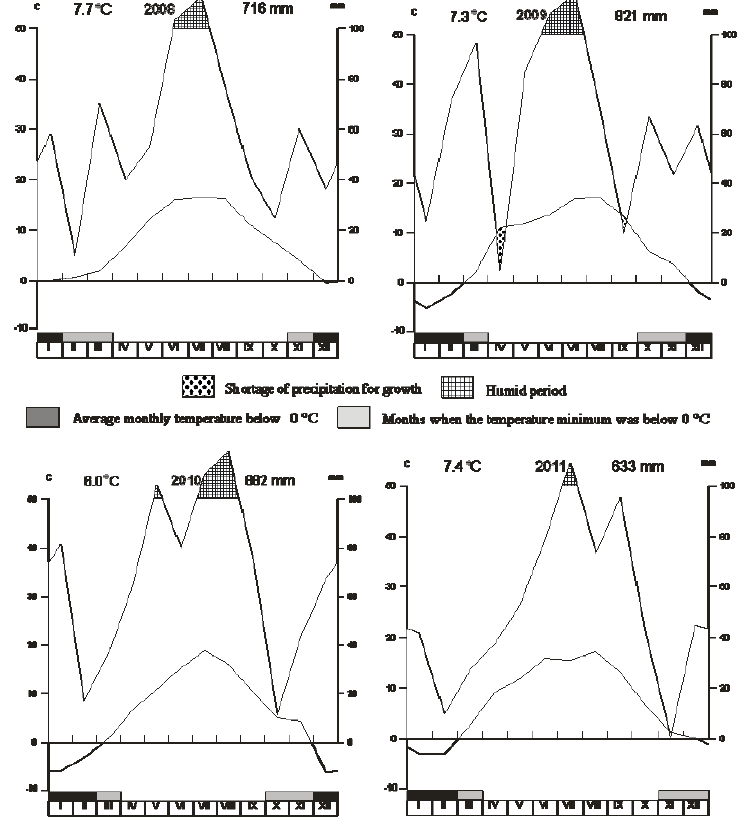
Figure 1. Precipitation and mean temperatures in years 2008–2011 at the Research Station of Fodder Crops, Vatín, Czech